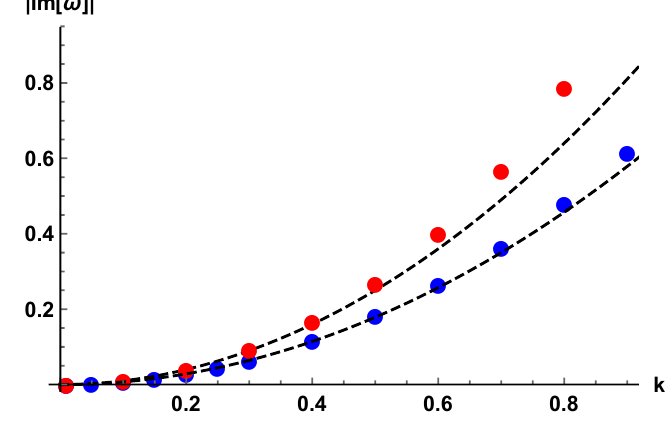
Figure 11 . The di(cid:11)usive mode in the decoupled scalar sector at m=T = 0 for N = 3 ; 5 (red, upper; blue, lower). The dashed line is the analytic